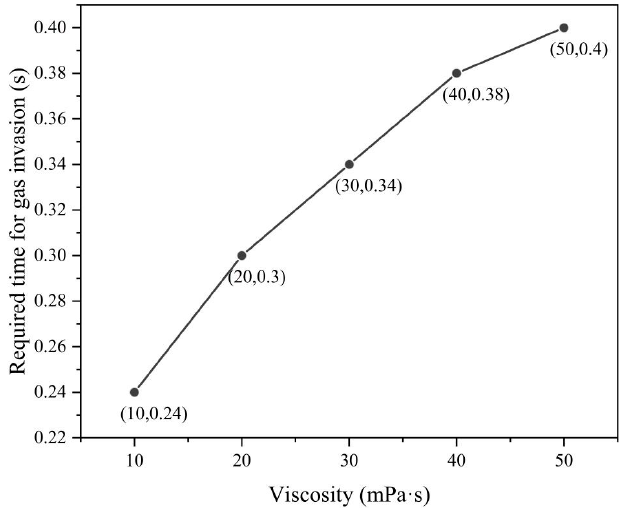
Figure 6. Time required for gas invasion under different drilling fluid